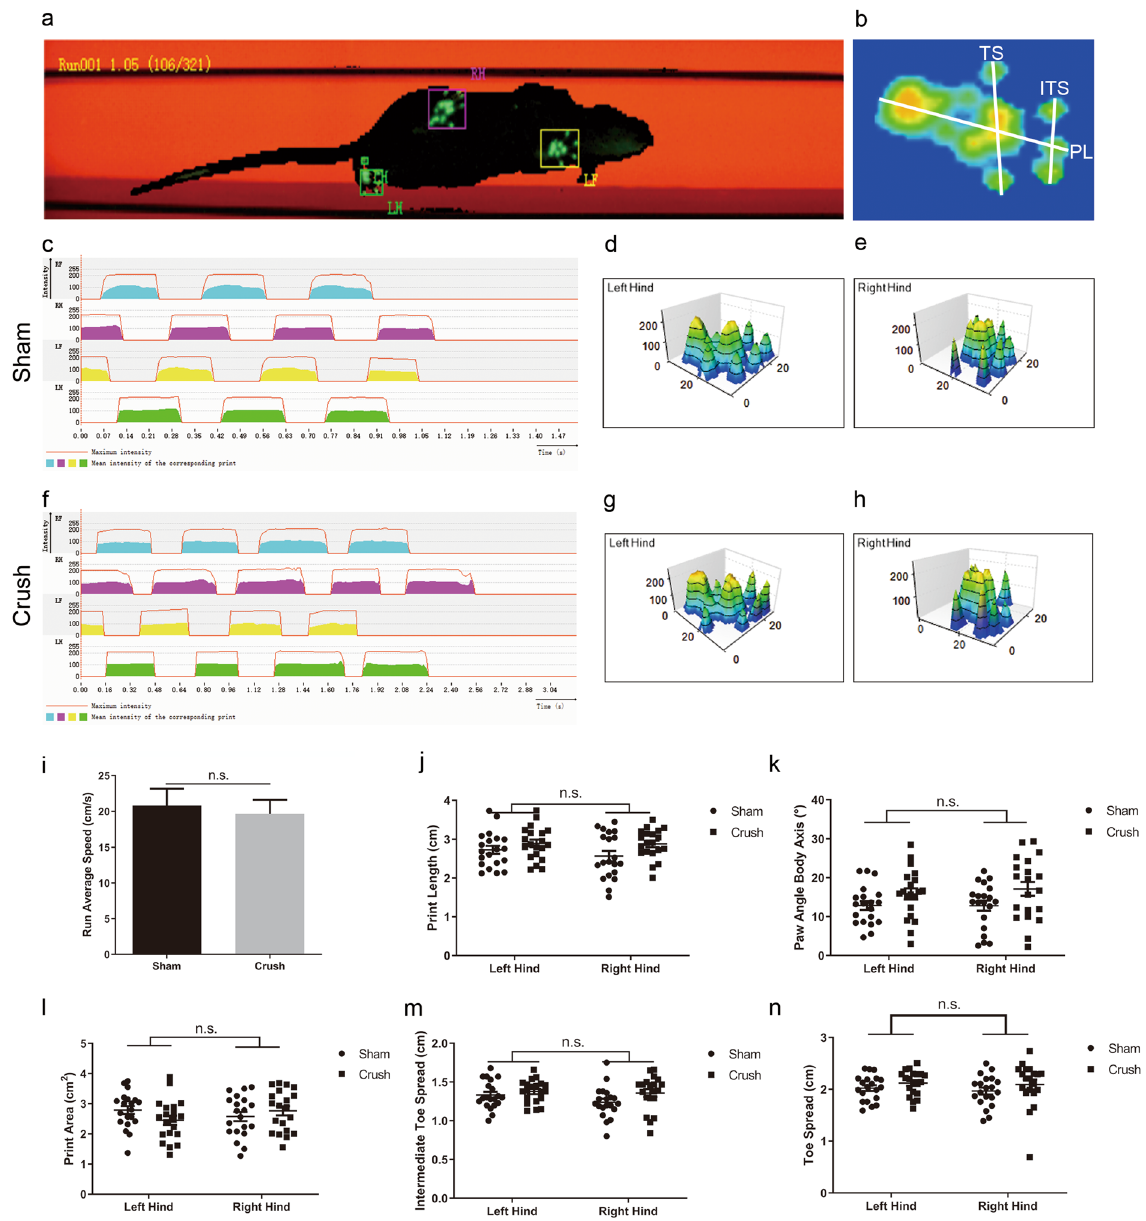
Figure 5. Gait analysis for judging the function of lower limbs in two groups. ( a ) Illustration of the walkway for gait analysis. ( b ) Examples of the footprint view and the measurements of toe spread (TS), intermediate toe spread (ITS) and print length (PL). ( c - h ) Examples of the 2D footprint intensities plot and 3D footprint intensities charts of rats in Sham and Crush group. The solid rad line represents the maximum intensity of the paw, the color-filled area under the rad line represents the mean intensity of the paw during the gait analysis. ( i ), Run Average Speed between two groups showed no statistical difference (N = 20/group). ( j - n ) Print Length (N = 20/group), Paw Angle Body Axis (N = 20/group), Print Area (N = 20/group), Intermediate Toe Spread (N = 20/group) and Toe Spread (N = 20/group) of two hinds between two groups all showed no significant difference. Homogeneity of variances was tested by using the Leneve’s analysis before two-way-ANOVA. Data was represented as mean ± SEM. Significance levels were set at n.s. P >